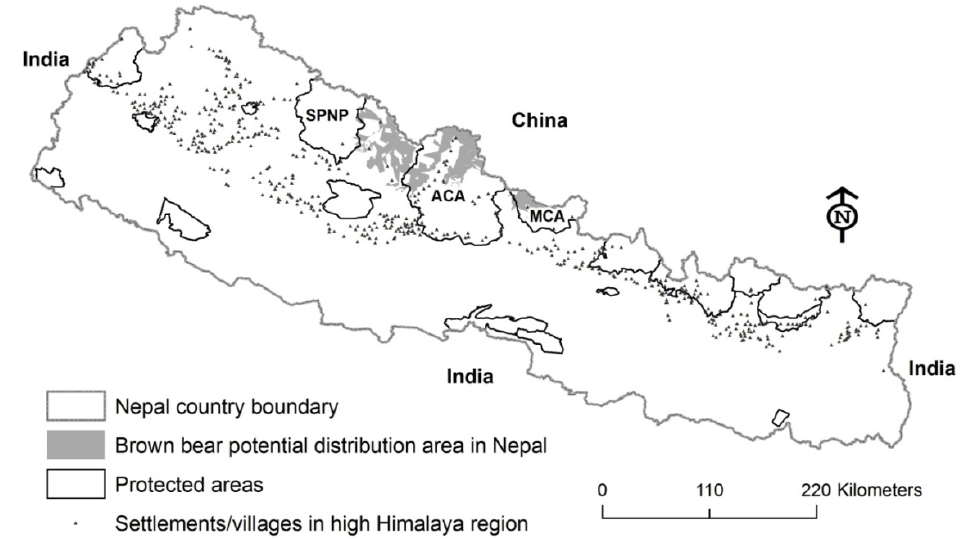
Figure 2. Potential brown bear distribution between the eastern border of Shey Phoksundo National Park (SPNP) and the Manasalu Conservation Area (MCA) predicted by our model.